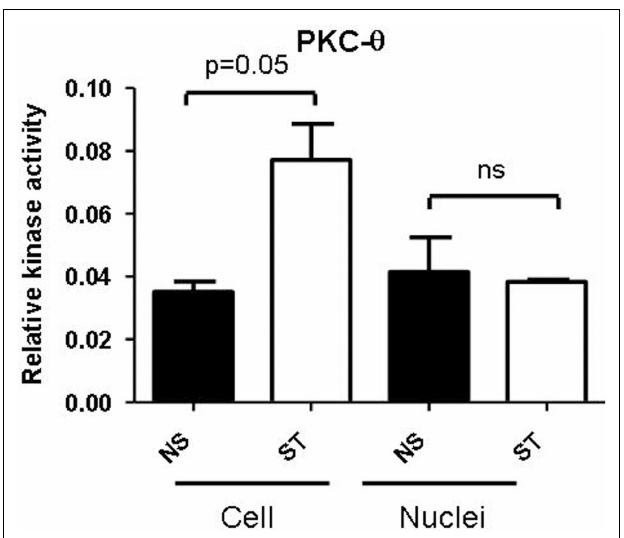
FIGURE 2 | PKC- θ activity inT lymphocytes. JurkatT cells were either non-stimulated (NS) or stimulated (ST) with PMA/CaI for 4h.The PKC- θ specific antibody was used to immunoprecipitate PKC- θ from either whole cells or nuclei from both NS and ST treated JurkatT cells. PKC ELISA-based kinase assays were performed on these PKC- θ fractions and absorbance was measured at 450nm. Data is plotted as relative kinase activity compared to the negative control that did not have any antibody. Data is representative of the mean ± SE of three independent experiments and statistical significance was determined by a two-tailed paired t -test using GraphPad Prism 5.03.